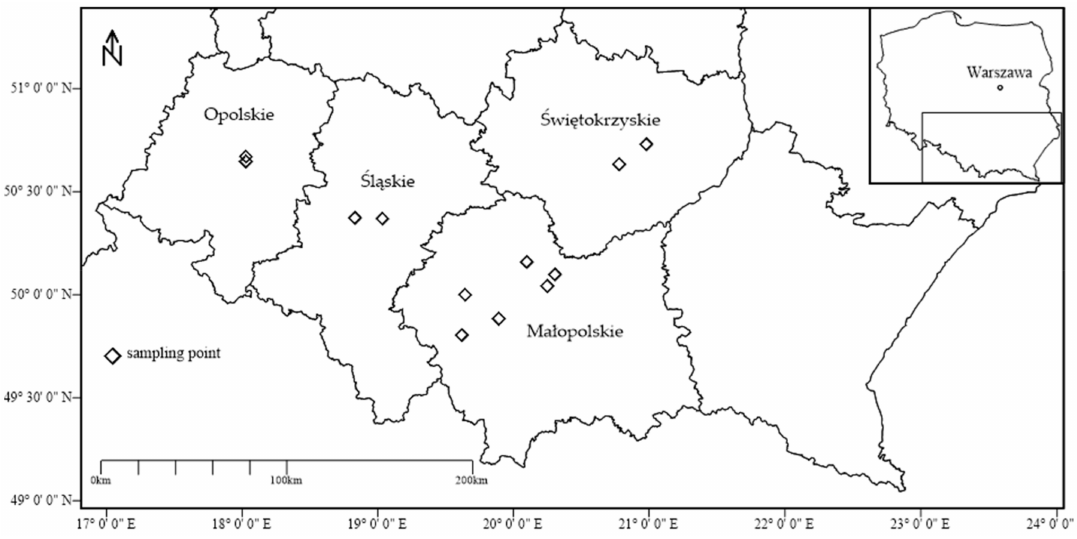
Figure 1. Cereal sampling site locations in the four regions of southern Poland (modified from [34]). Table 1. Description of the cereals investigated in this